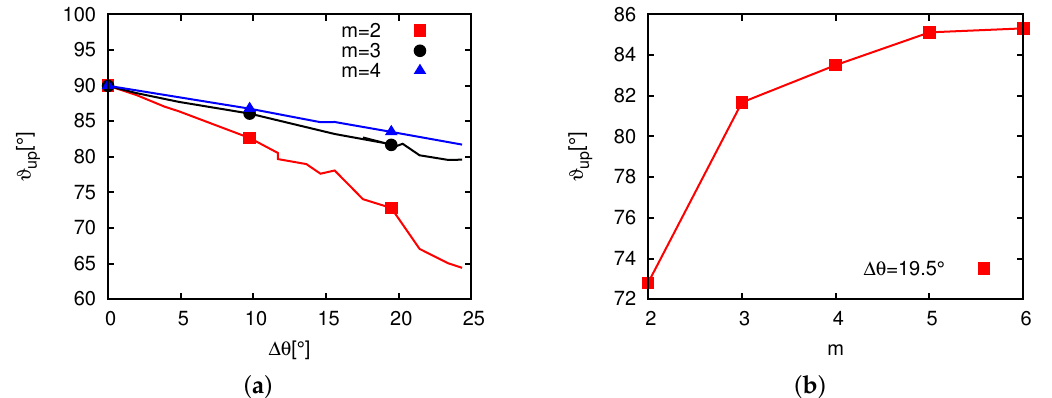
Figure 4. ( a ) The final value of the angle ϑ up after the adsorption of the particle to the fluid interface in the tilted state is shown for a constant aspect ratio m and as a function of the Janus parameter ∆ θ . ( b ) The final angle ϑ up of the particle after the adsorption to a fluid interface in the tilted state is shown for a constant ∆ θ and depending on m